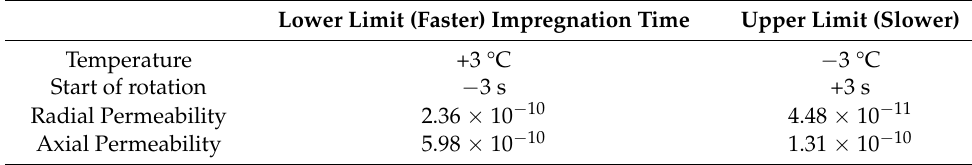
Table 10. Lower and upper simulation